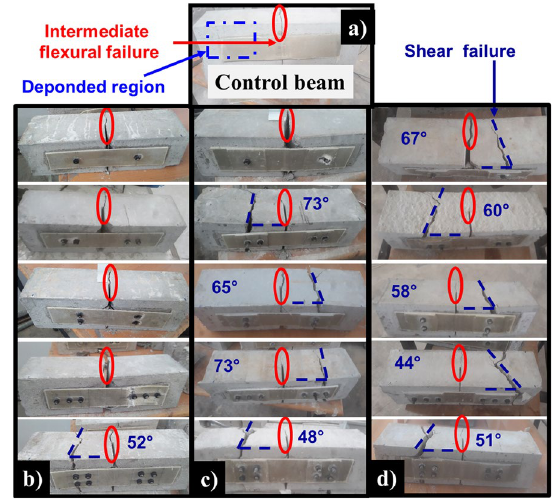
Fig. 7 Typical failure modes for beams strengthened with bolt (diameter 10 mm)-glass fiber polymer composites (BGFPC) systems: a control beam; b without using end-anchorage GFRP; c end anchorage GFRP of 2.4 mm thickness; d end-anchorage GFRP of